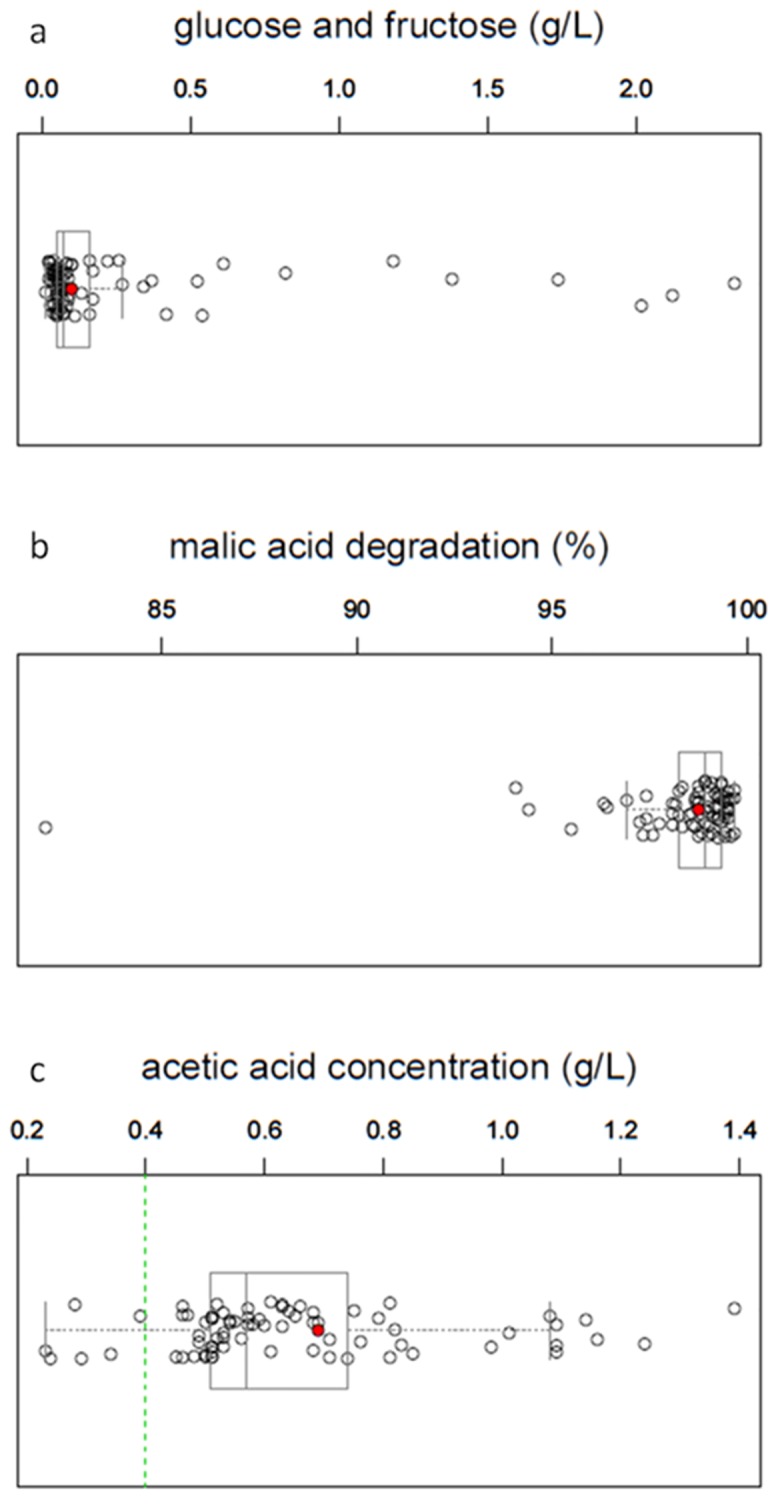
(a) Glucose + fructose concentrations (g/L); (b) malic acid degradation (%); (c) acetic acid concentration (g/L).Scatterplots and box-and-whisker plots for the mean values of the final fermentations for the 75 studied S. pombe strains after 21. The red points indicate the values of the standard laboratory reference strain (Leupolds, 972, 975, 978), green line indicates values of strains with low levels of acetic acid (<0.4 g/L).